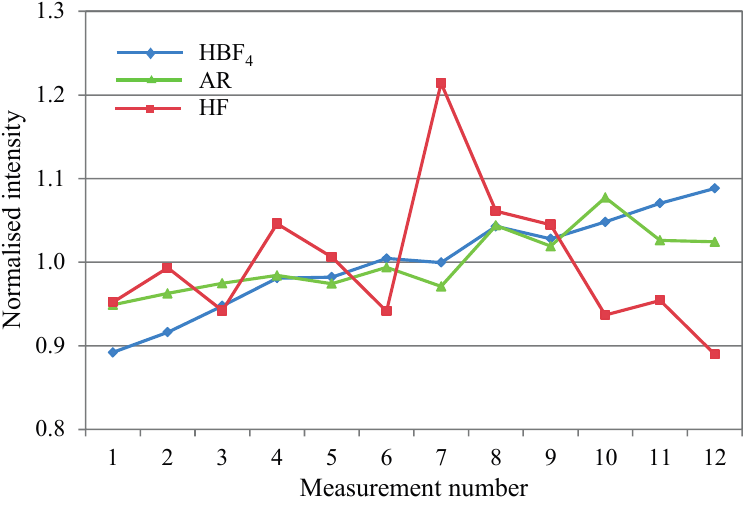
Figure 4. Mercury drift plot, showing anomalous drift in the HF